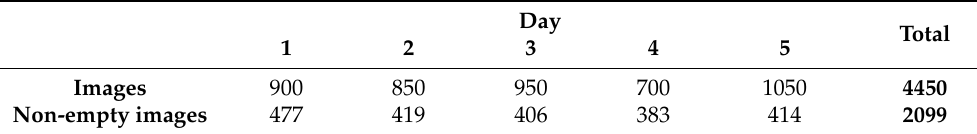
Table 2. Day-wise splitting of data. All images in the dataset were acquired in the same week from 27 April to 1 May in 2020. The second row states how many instances with polar bears were used (excluding empty